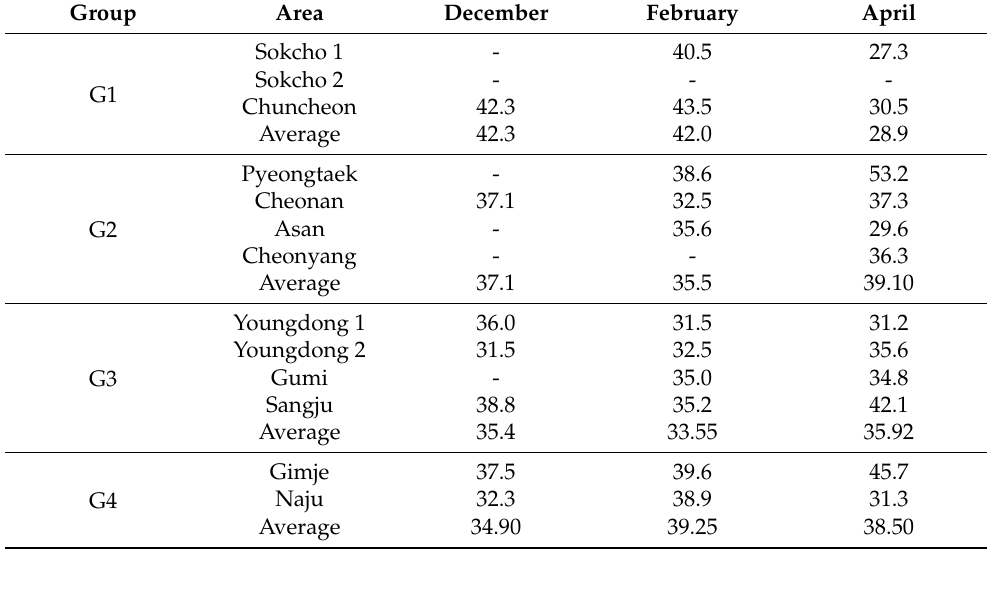
Table 6. Soil moisture contents in December, February, and April in different group areas in 2020.